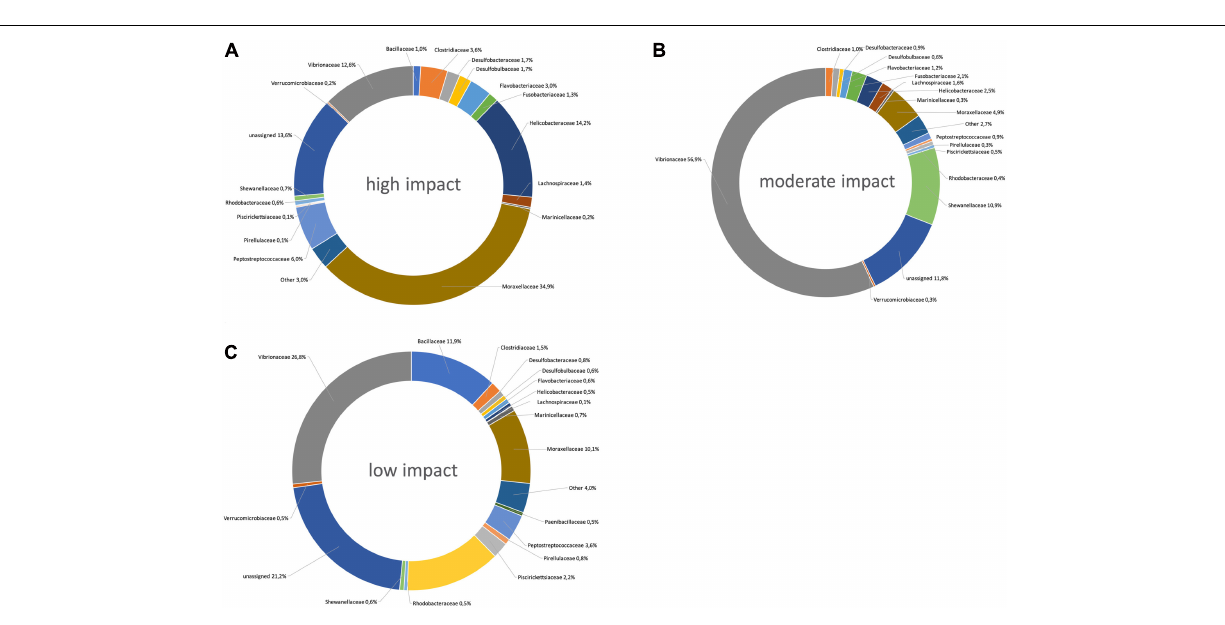
FIGURE 4 | Pie charts showing the taxonomic distribution (relative abundances) of bacterial taxon ranks at high (A) , moderate (B) , and low (C) aquaculture-related impact